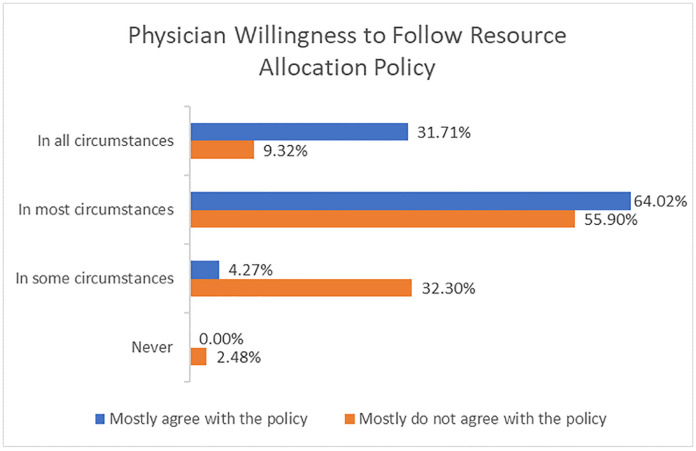
Physician willingness to follow resource allocation policy.Physician willingness to follow an institutional policy on resource allocation, measured on a 4-point scale from in all circumstances to never, differentiated by whether the respondent mostly agrees with the policy or mostly does not agree with the policy.